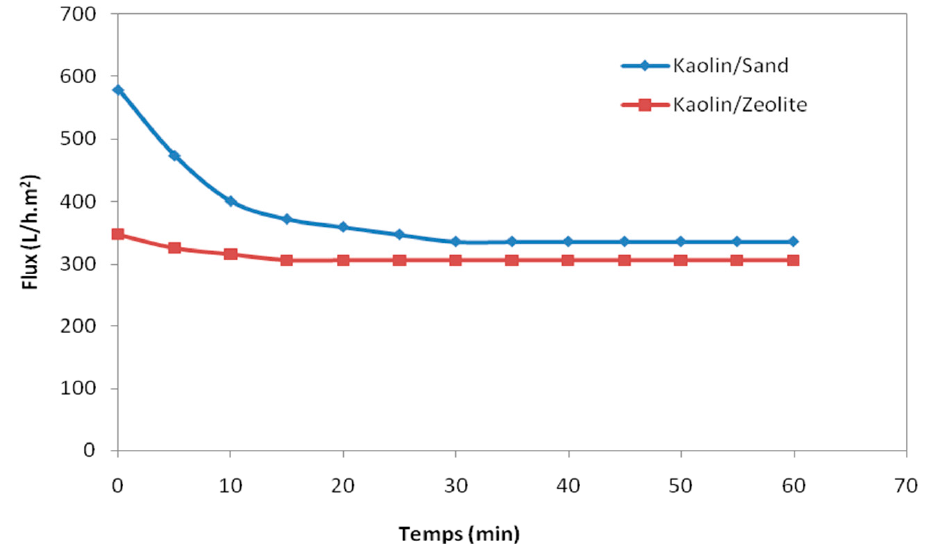
Figure 6. Permeate flux of kaolin/sand and kaolin/zeolite membranes as a function of time.